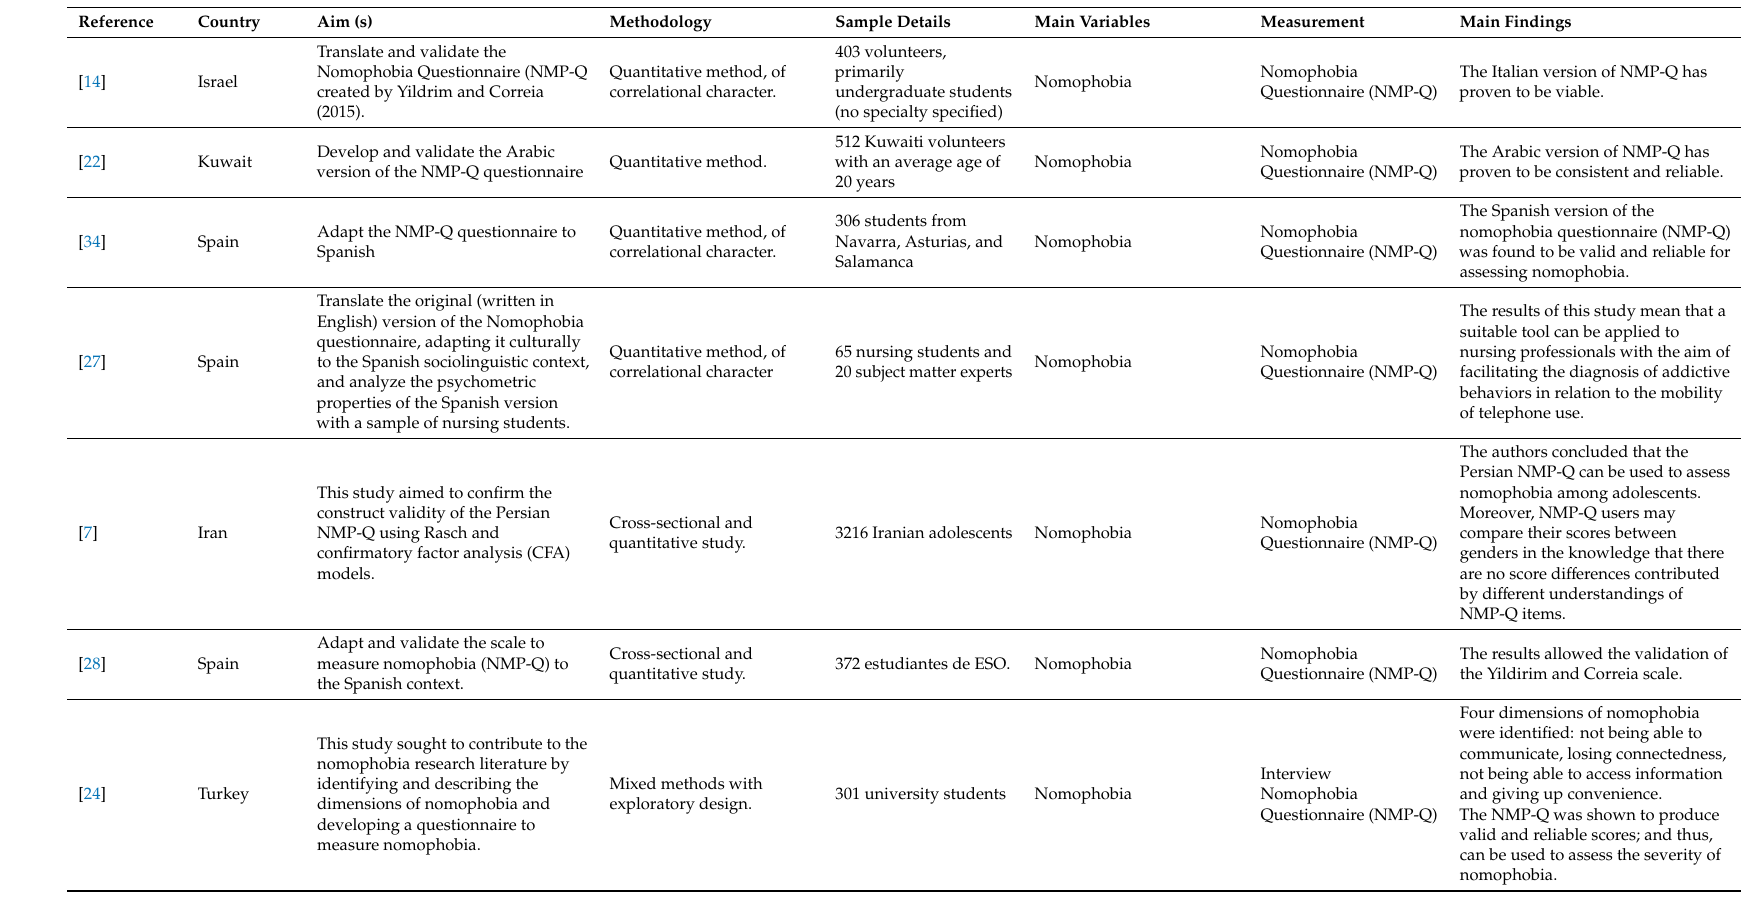
Table A2. Adaptation and validation of questionnaires to measure